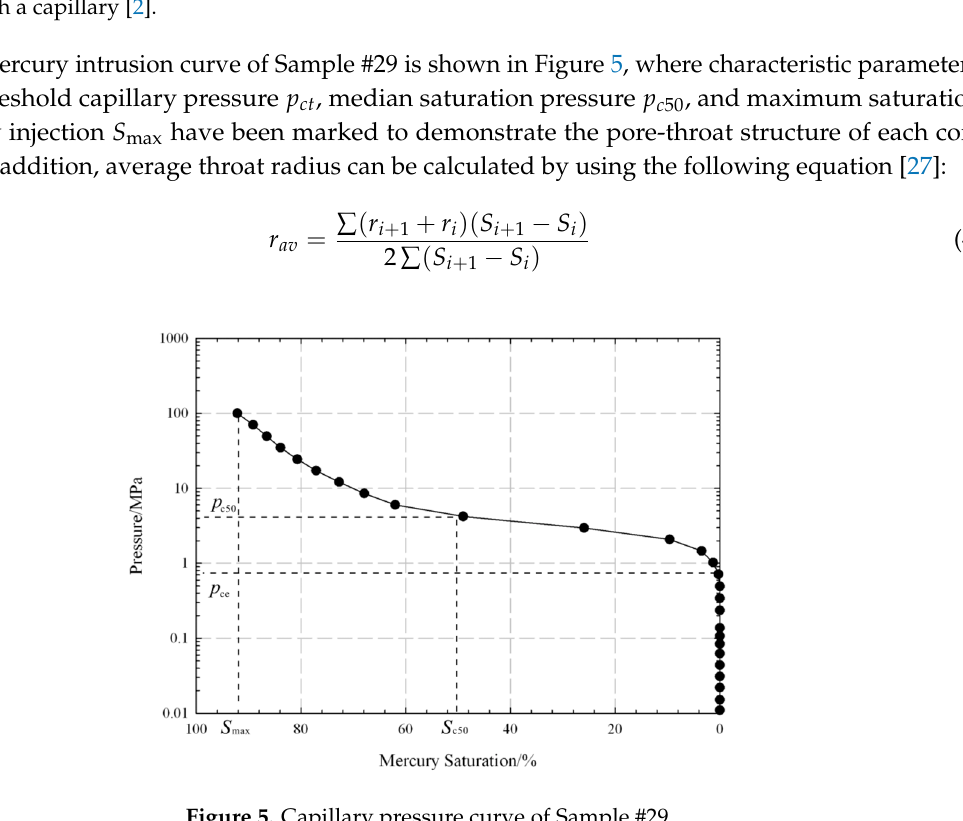
Figure 5. Capillary pressure curve of Sample #29.